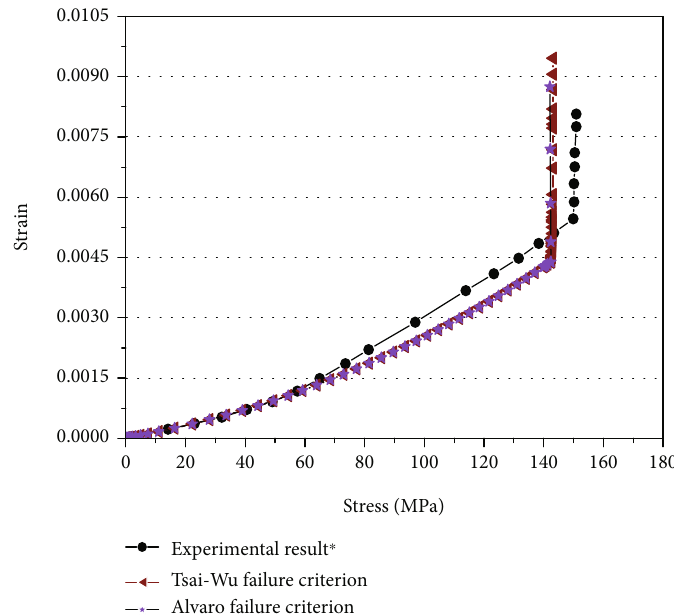
Figure 4: Comparison of simulated tensile stress and strain relationship by using Tsai-Wu and 3D Alvaro failure criteria with experimental results in Li et al. [33] for 2D plain-woven C/SiC composite open-hole